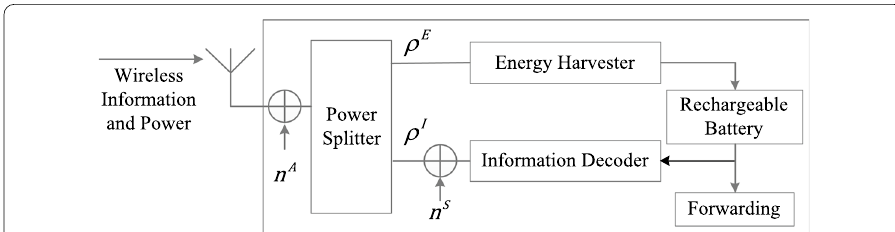
Fig. 2 A diagram of a node with